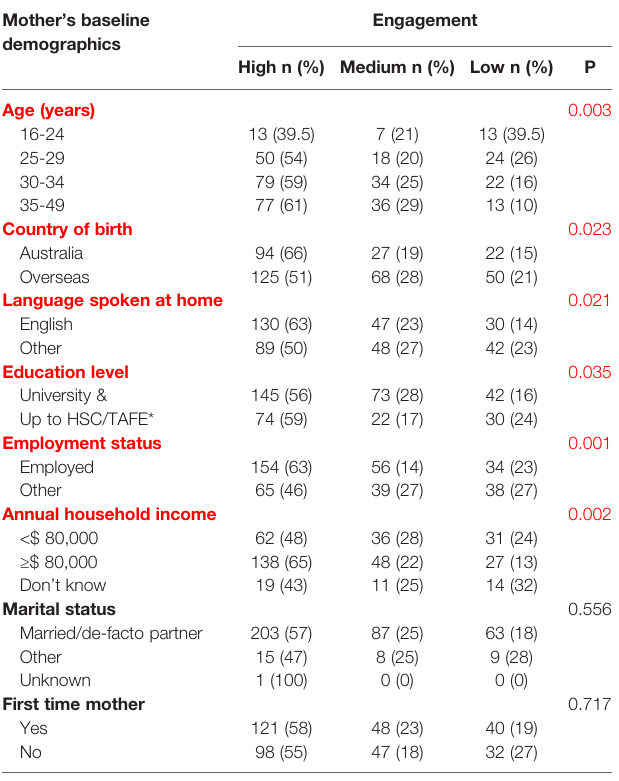
TABLE 4 | Representation of themes discussed during intervention provision from intervention providers ’ notes on a sample of participants (N=30) using